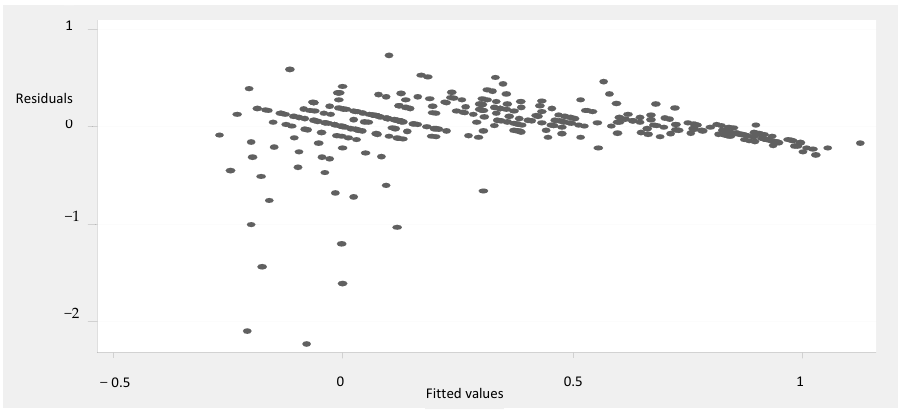
Figure 4. Curvy-linear relationship between inputs and output.